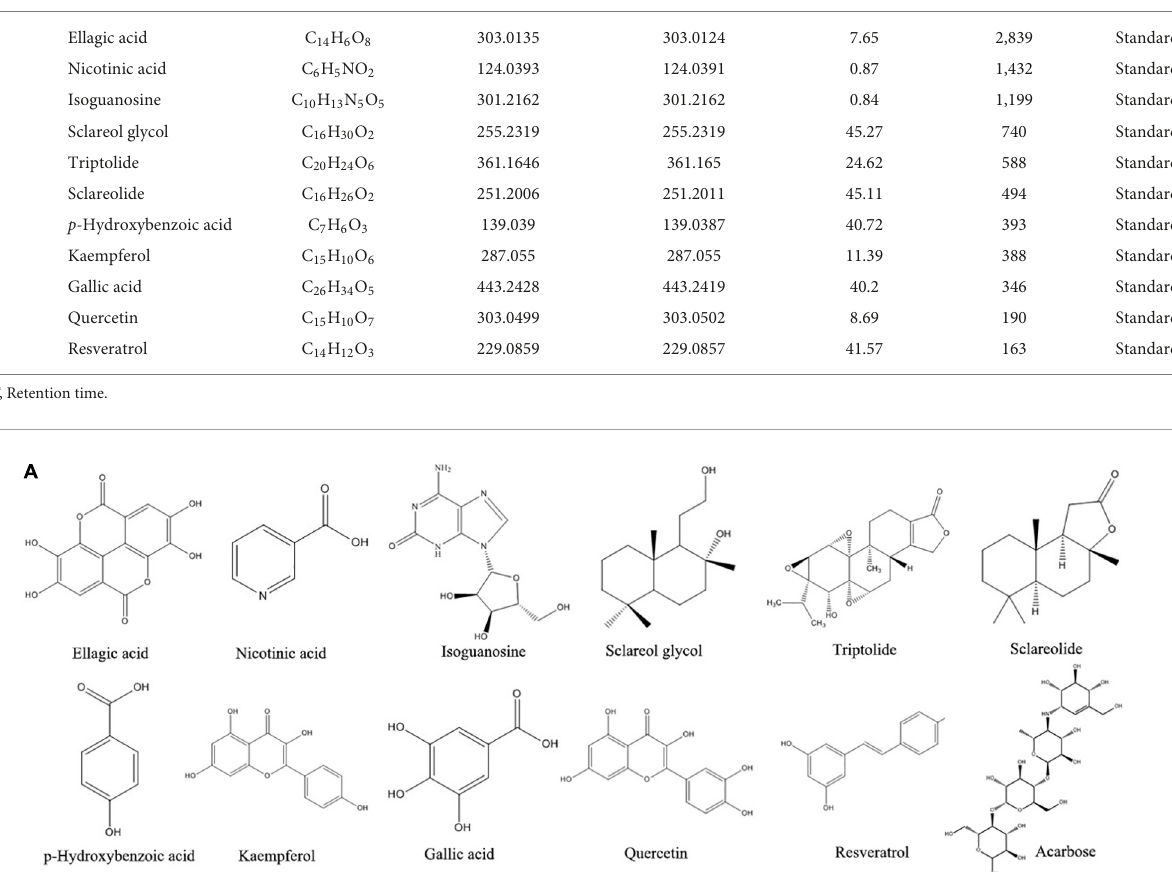
TABLE 1 Identification of the main potential α -glucosidase inhibitors from the acetone extract of pomegranate peel. No.